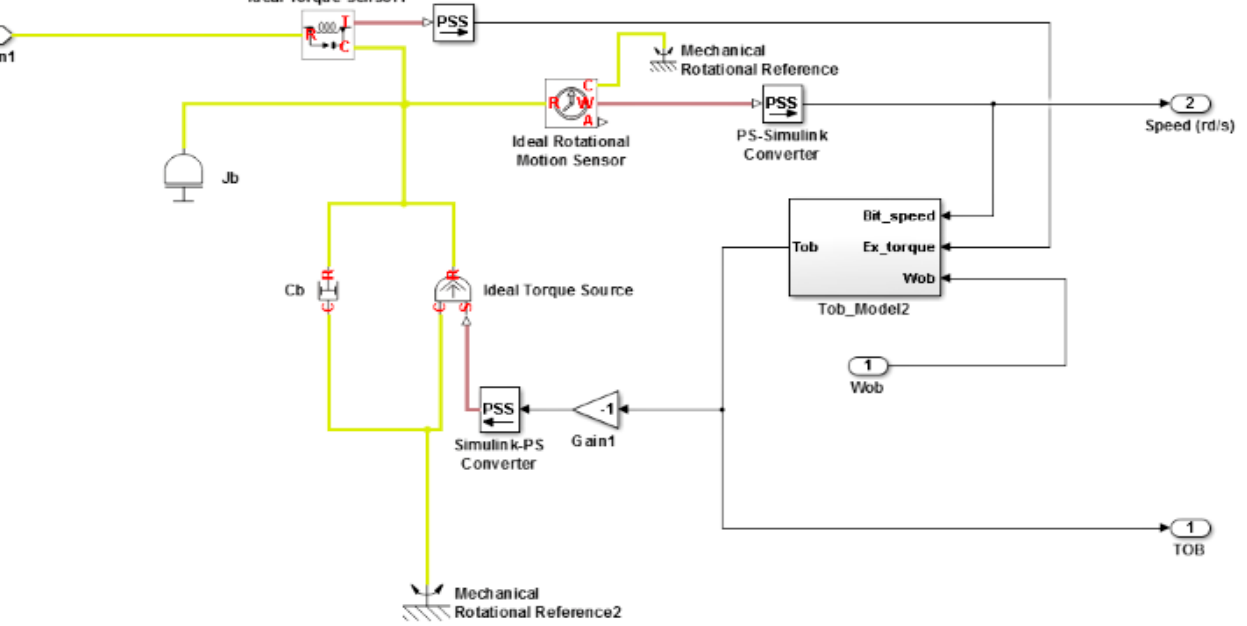
Figure 2. Simscape/Matlab Block diagram of Rock-bit interaction simulation model.